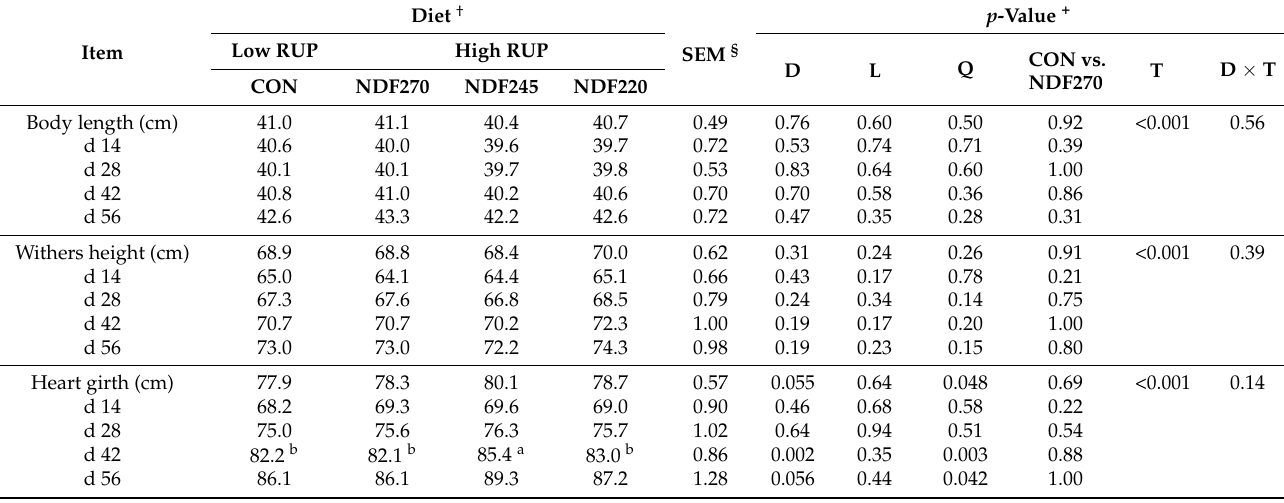
Table 3. Body dimensions in lambs receiving diets with various levels of neutral detergent fiber (NDF) and rumen undegradable protein